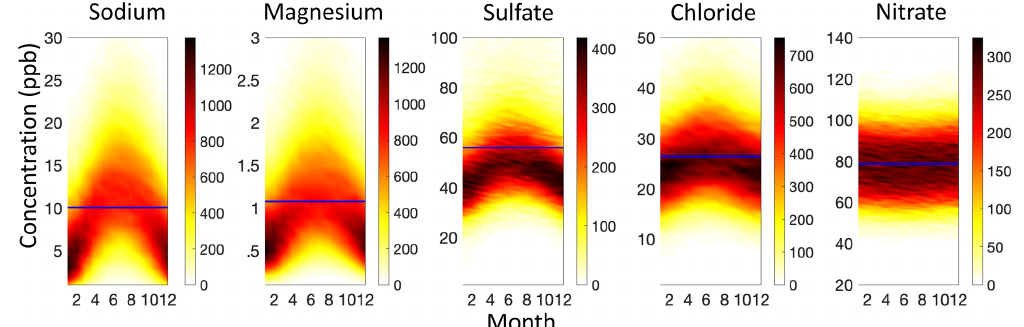
Figure 3. Seasonal variation in magnesium, sodium, sulfate, chloride and nitrate ion concentration in SPICEcore from − 42 to 11341BP (11383 total years). In each panel, the horizontal axis is month of the year (with 0 being 1 January) from linear interpolation between mean sample depth and the timescale. The vertical axis is concentration (ppb). The color scale indicates the density of measurements within gridded month and concentration bins. Concentration bin widths are 1 month (without claiming 1 month precision) and 1ppb except for magnesium, which is 0.1ppb. The Holocene mean concentration of each ion is shown as a blue bar. Strong annual cyclicity is apparent in sodium and magnesium data. Annual cyclicity is weaker in sulfate, chloride and nitrate data.